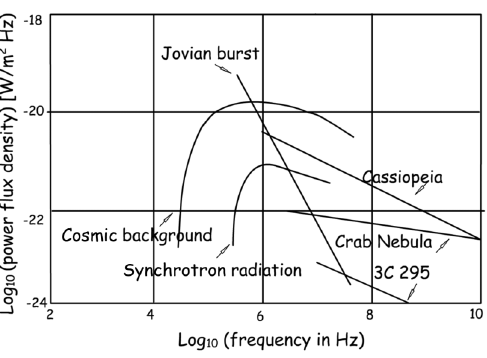
Fig. 9. Some sources of radio emissions and cos- mic